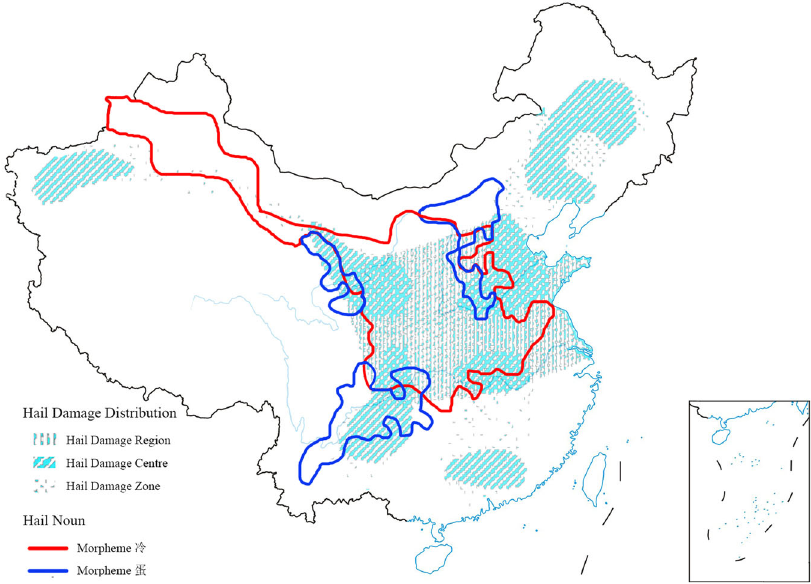
Fig. 4 Map of distribution of hail nouns and hail damage areas. The different patterns in light blue represent the area with hail damage, the red and blue lines are the isoglosses of different morphemes used in hail